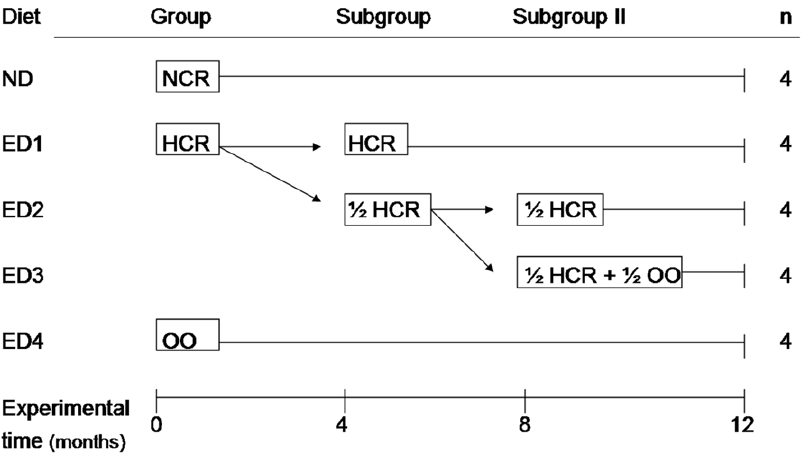
Figure 1. Experimental groups. Twenty New Zealand rabbits were initially distributed at random in three groups: NCR, HCR, OO at 5 months of age (corresponding to experimental time (et)=0 months). After 4 months, NCR continued with normal diet (ND) and HCR was split in two subgroups: HCR and K HCR. HCR continued with experimental diet 1 (ED1) and the last group was fed with ED2. Four months later (et=8 m) K HCR was divided again in two (subgroup II): K HCR (fed with ED2) and K HCR + K OO (fed with ED3). m=months, n=number of experimental animals. More details in the text.